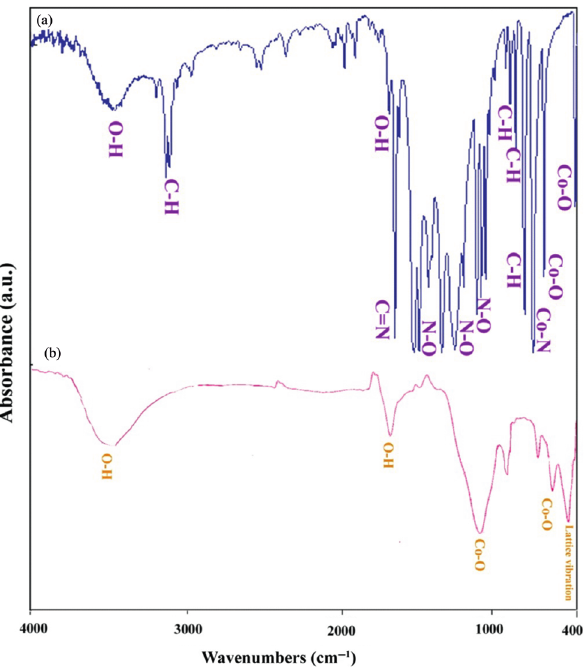
Figure 3: FT-IR spectra of (a ) [Co(py) 2 (H 2 O) 2 (NO 3 ) 2 ] and (b ) Co 3 O 4 nanostructures.